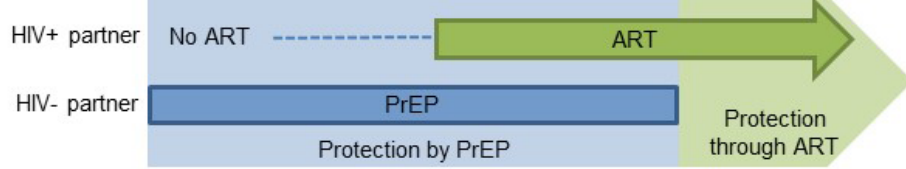
Figure 1. Strategy for PrEP delivery to HIV-negative persons with a partner known to be living with